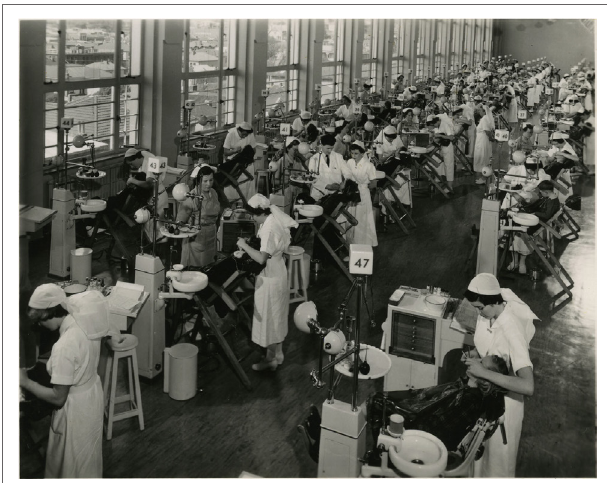
FiguRe 6 | The Dominion School for Dental Nurses, Wellington—showing many students and staff, early 1950s [Archives New Zealand/Te Rua Mahara o te Kawanatanga, Wellington Office (Archives Reference: ABKI 667/3)].